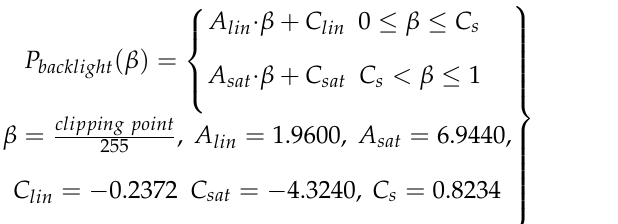
Table 1 tabulates the power of some example clipping